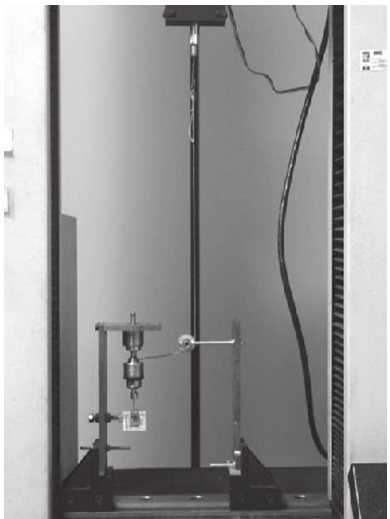
Figure 1. Device attached to Universal Mechanical Testing Machine.